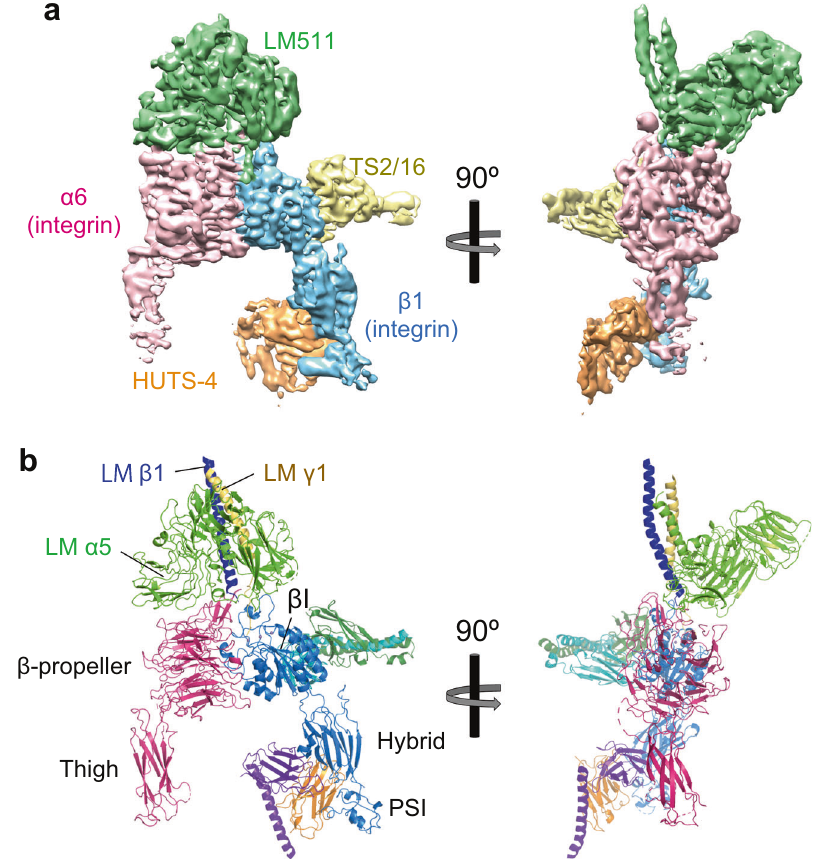
Fig. 3 Cryo-EM structure of a quaternary complex of the α 6 β 1 headpiece, tLM511, TS2/16 Fv-clasp, and HUTS-4 Fv-clasp. a Cryo-EM density map. The map is colored as follows; integrin α 6 subunit in pale pink, integrin β 1 subunit in light blue, LM511 in pale green, TS2/16 Fv-clasp in pale yellow, and HUTS-4 Fv-clasp in pale orange. The map is drawn at the contour level of 0.05 in Chimera. b Ribbon diagram of the atomic model of the quaternary complex. Integrin and TS2/16 are shown in the same color scheme as Fig. 1c. Laminin α 5, β 1, and γ 1 chains are shown in light green, blue, and yellow, respectively. V H -SARAH and V L -SARAH of HUTS-4 Fv-clasp are shown in orange and purple,